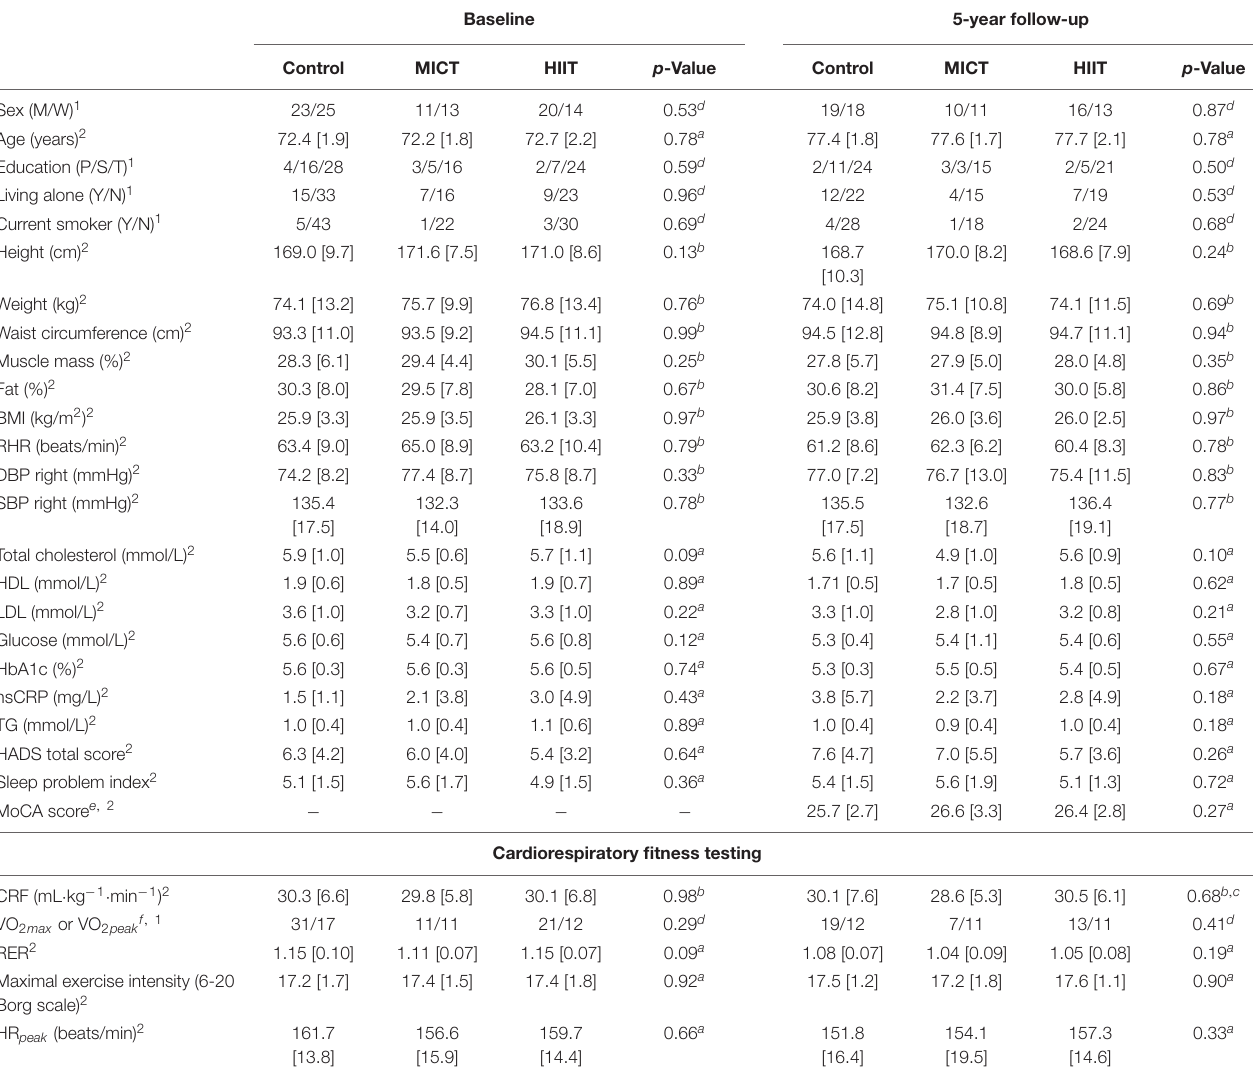
TABLE 2 | Demographics, physical measures, and clinical variables for the control group, the moderate intensity continuous training group (MICT), and the high intensity interval training group (HIIT) at baseline and 5-year follow-up. Baseline 5-year